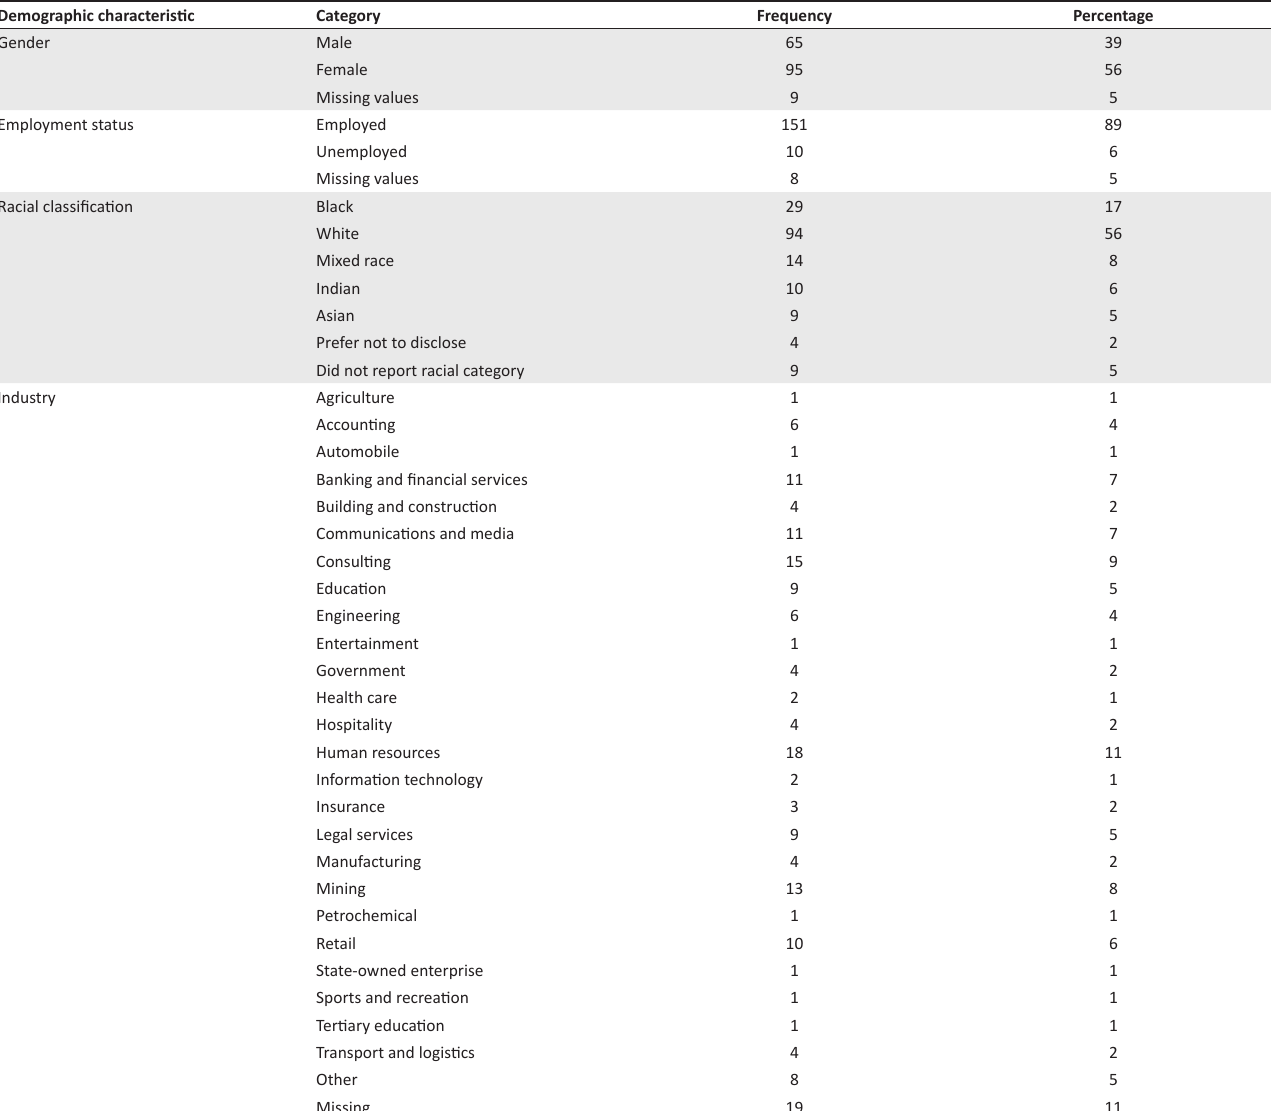
TABLE 2: Demographic characteristics of the